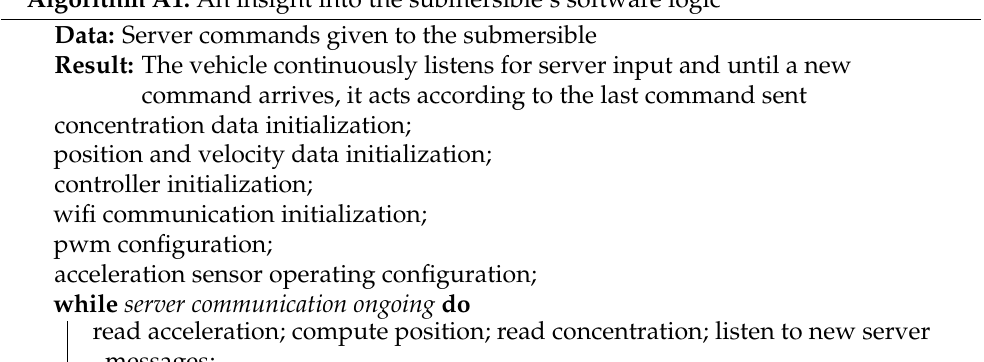
Algorithm A1: An insight into the submersible’s software logic